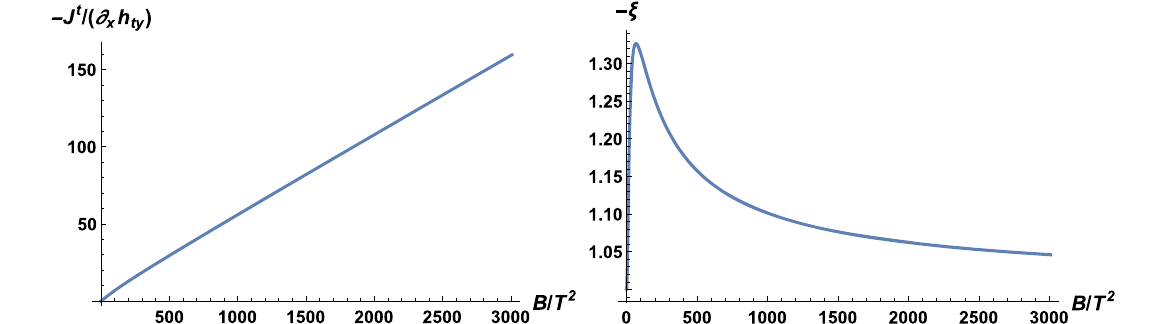
Fig. 1 The correlator (cid:13) J t T ty (cid:14) /( iq ) = J t /∂ x h ty in units of r 2